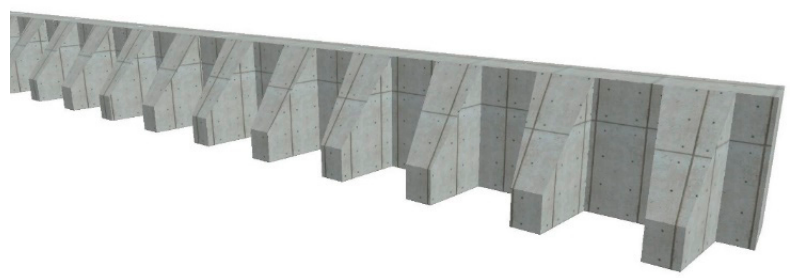
Figure 6. A row of a spur dike with tooth-shaped structures.